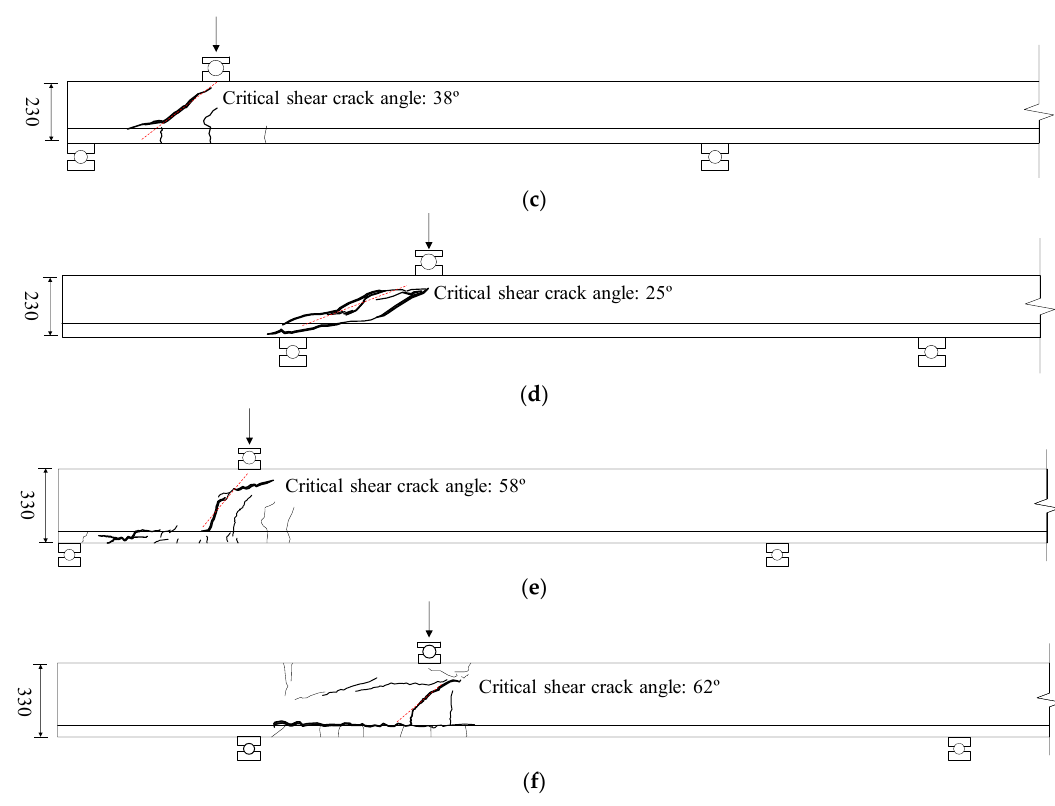
Figure 4. Crack patterns of test specimens at failure; ( a ) UF specimen; ( b ) CF specimen; ( c ) USt specimen; ( d ) USf specimen; ( e ) CSt specimen; ( f ) CSf specimen.